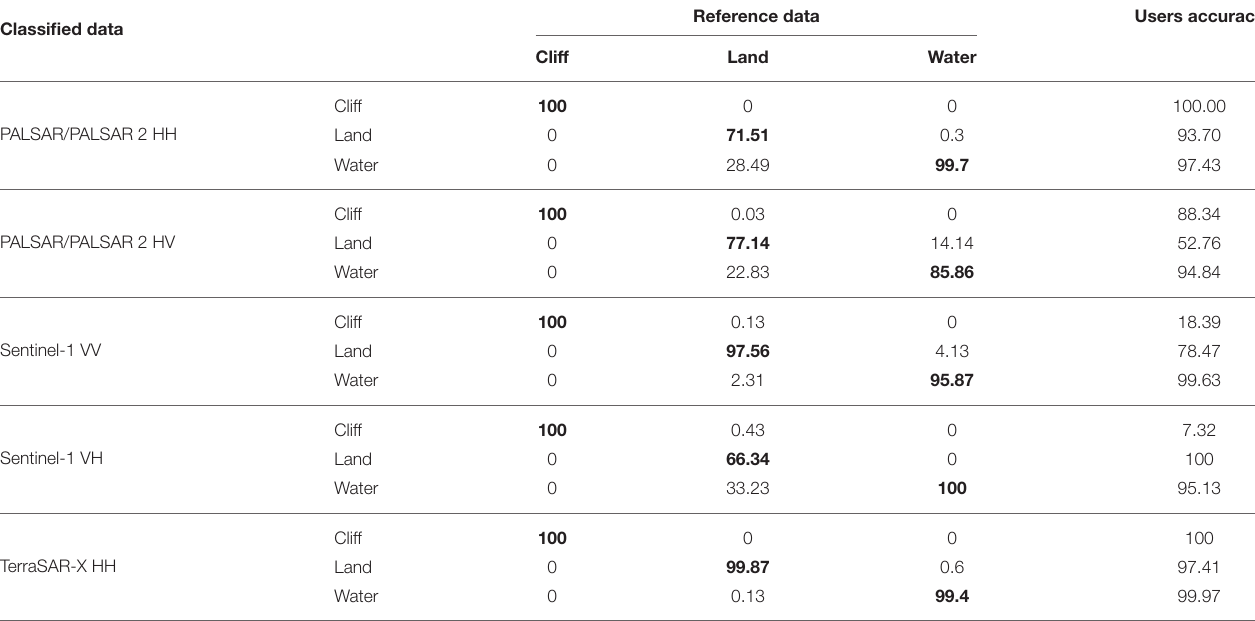
TABLE 4 | User’s and producers accuracy of landcover classifications. Classified